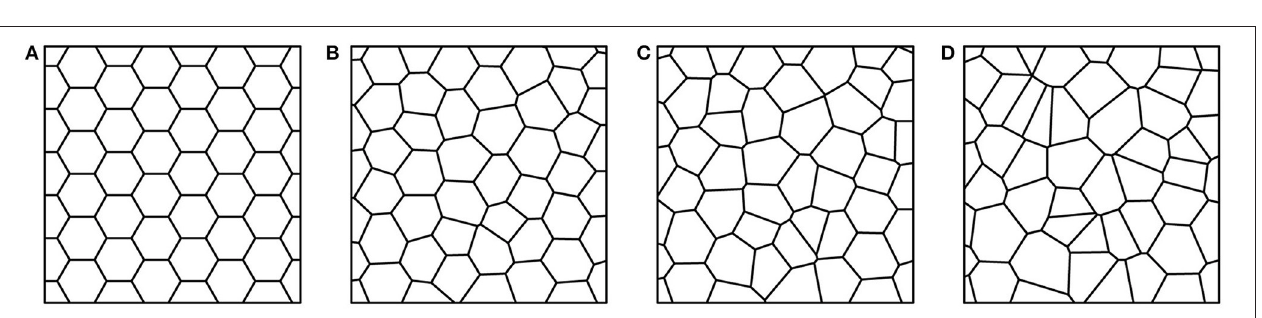
FIGURE 4 | Voronoi tessellation with varying α : (A) regular α